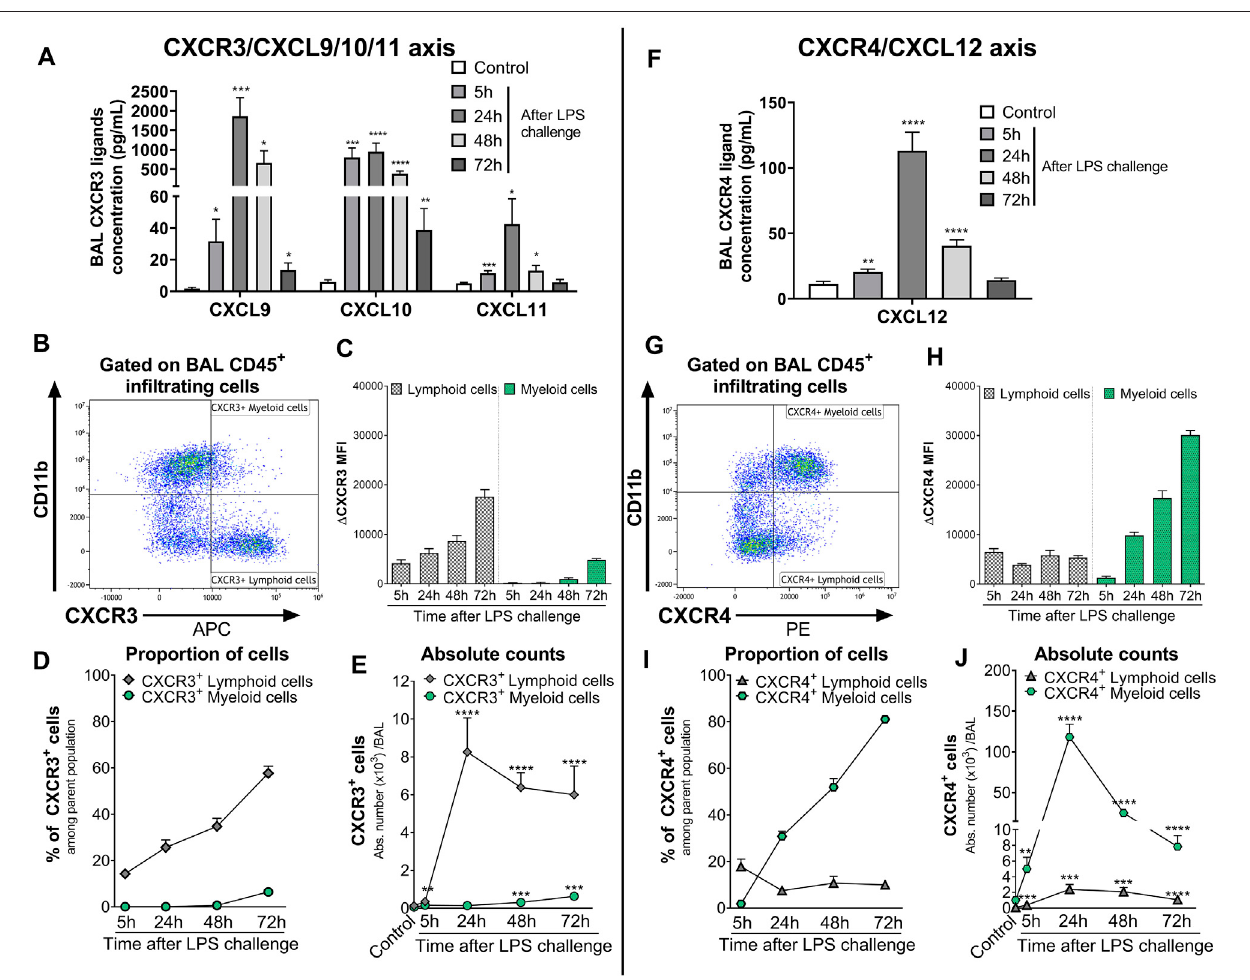
FIGURE2| KineticsoftheexpressionofCXCR3/CXCR4anditsligandsintheBALofLPS-challengedDBA/1mice.ALIwasinducedbynebulizedLPSinhalationin male DBA/1 mice. Control mice inhaled NaCl 0.9% ( n (cid:1) 12 mice; all time points were pooled). (A) LPS inhalation increased protein concentrations of the CXCR3 ligands CXCL9, CXCL10, and CXCL11, measured in the BAL 5, 24, 48, and 72 h following LPS challenge, compared with control mice. Results are expressed as mean ± SEM ( n (cid:1) 8 mice per time point). * p < 0.05, ** p < 0.01, *** p < 0.001, **** p < 0.0001 versus control mice using Student t -test. (B) Representative gating strategy for CXCR3 + myeloid and lymphoid cells. (C) CXCR3 expression on BAL lymphoid and myeloid-in fi ltrating cells. Results are expressed as mean ± SEM of the mean fl uorescence intensity (MFI) of CXCR3 obtained for each LPS-challenged mouse ( n (cid:1) 7 – 8 mice per time point) corrected by the MFI obtained in the fl uorescence minus one (FMO) controls for CXCR3. Negative MFI values were set to 0. The complete gating strategy for lymphoid and myeloid cells is illustrated in Supplementary Figure S3 . (D) Proportion of CXCR3 + lymphoid and myeloid cells expressed as percentages (mean ± SEM) of the CD45 + CD11b − and CD45 + CD11b + parent population, respectively, in the BAL (see gating strategy in Supplementary Figure S3 ) ( n (cid:1) 7 – 8 mice per time point). (E) Time course of BAL CXCR3 + lymphoid and myeloid cell in fi ltrates. Results are expressed as absolute counts in the BAL (mean ± SEM). ** p < 0.01, *** p < 0.001, **** p < 0.0001 using Student t -test versus control mice. (F) LPS inhalation increased protein concentrations of the CXCR4 ligand CXCL12, measured in the BAL 5, 24, 48, and 72 h following LPS nebulization compared with control mice.Resultsareexpressedasmean ± SEM( n (cid:1) 7 – 8micepertimepoint).** p < 0.01,**** p < 0.0001versuscontrolmiceusingStudent t -test. (G) Representativegating strategyforCXCR4 + myeloidandlymphoidcells. (H) CXCR4expressiononBALlymphoidandmyeloid-in fi ltratingcells.Resultsareexpressedasmean ± SEMoftheMFI of CXCR4 obtained for each LPS-challenged mouse ( n (cid:1) 7 – 8 mice per time point) corrected by the MFI obtained in the FMO controls for CXCR4. Negative MFI values were set to 0. The gating strategy for lymphoid and myeloid cells is illustrated in Supplementary Figure S3 . (I) Proportion of CXCR4 + lymphoid and myeloid cells expressed as percentages (mean ± SEM) of the CD45 + CD11b − and CD45 + CD11b + parent population, respectively, in the BAL (see gating strategy in Supplementary Figure S3 ) ( n (cid:1) 7 – 8 mice per time point). (H) Time course of BAL CXCR4 + lymphoid and myeloid cell in fi ltrates. Results are expressed as absolute counts in the BAL (mean ± SEM) ( n (cid:1) 7 – 8 mice per time point). ** p < 0.01, *** p < 0.001, **** p < 0.0001 using Student t -test versus control mice.